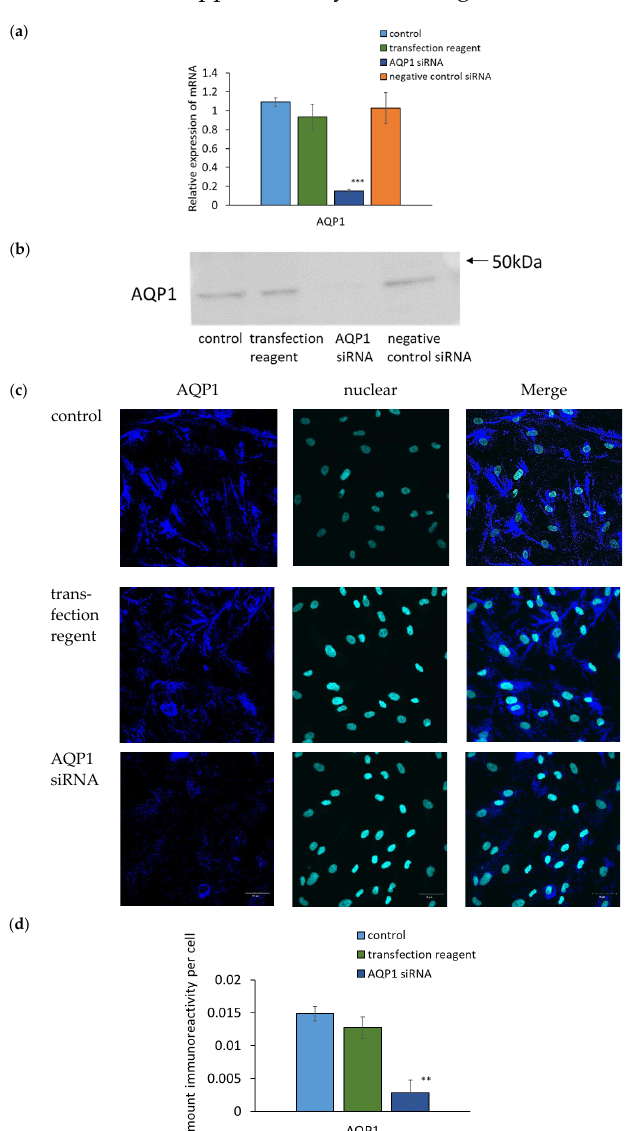
Figure 1. ( a ) AQP1 mRNA expression levels in cultured human dermal fibroblasts after AQP1 depletion for 3 days by AQP1 siRNA in cultured human dermal fibroblasts. ( b )Western blotting for AQP1 in cultured human dermal fibroblasts following AQP1 depletion by AQP1 siRNA. ( c ) Antibody staining for AQP1 in cultured human dermal fibroblasts following AQP1 depletion by AQP1 siRNA. ( d ) Image analysis of the amount of immunoreactivity per cell using ImageJ. ***: p < 0.001 vs. the transfection reagent. **: p < 0.01 vs. the transfection reagent. The figure shows the means ± standard deviations ( n = 3).